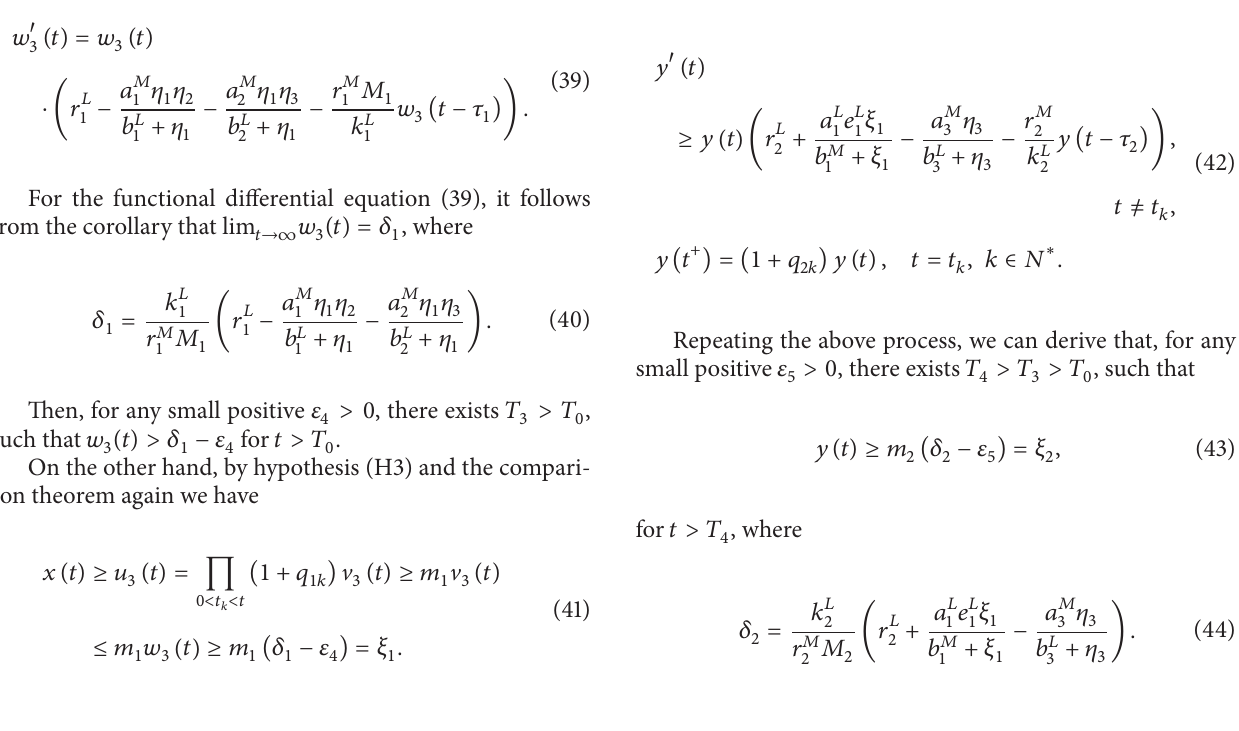
and the comparison equation of (38)